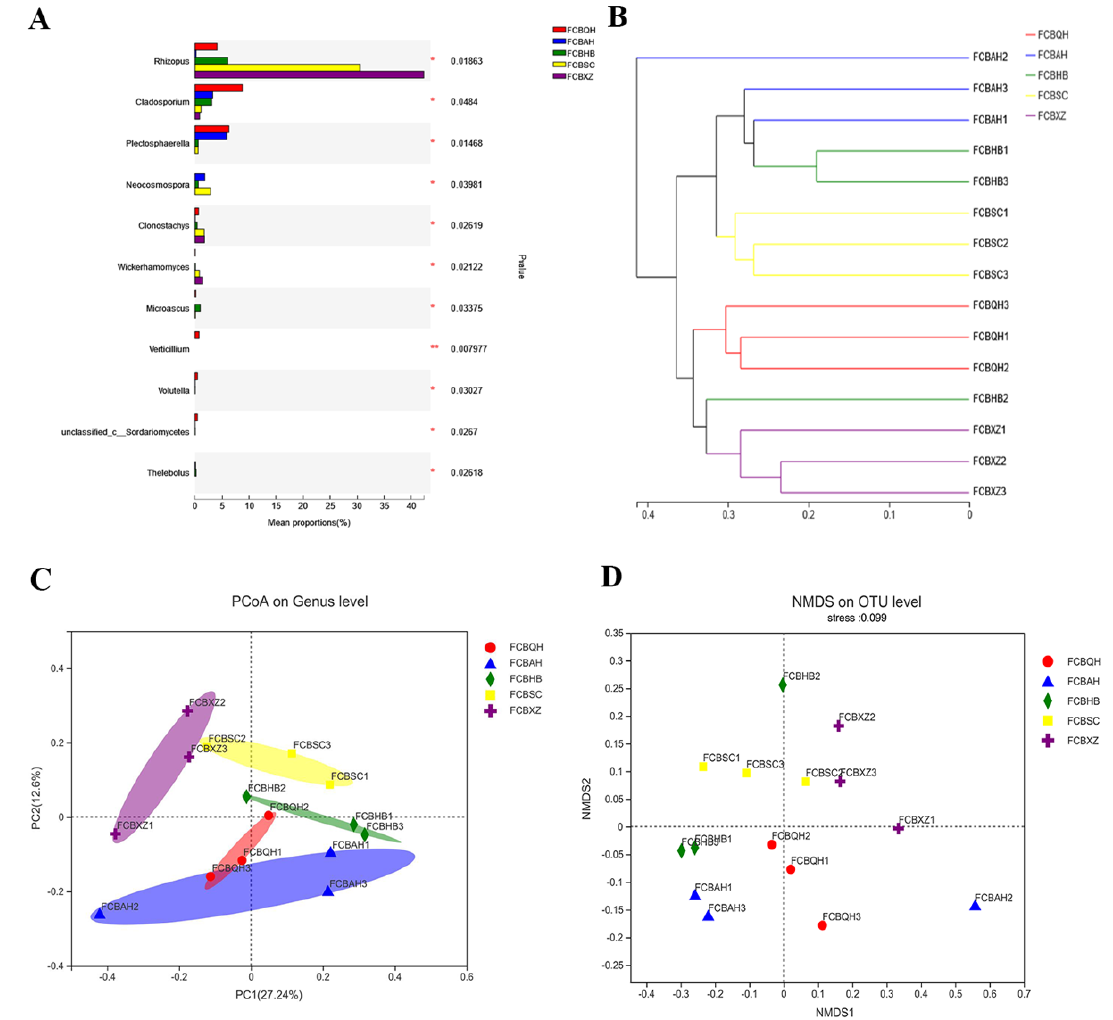
Figure 4. ( A ) Significant difference test on FCB groups via the Kruskal − Wallis H test; ( B ) hierarchical clustering analysis of the fungal community in five FCB groups at the OTU level; ( C ) PCoA plot at the genus level generated through the Bray − Curtis; ( D ) NMDS plot at the OTU level estimated with unweighted unifrac.